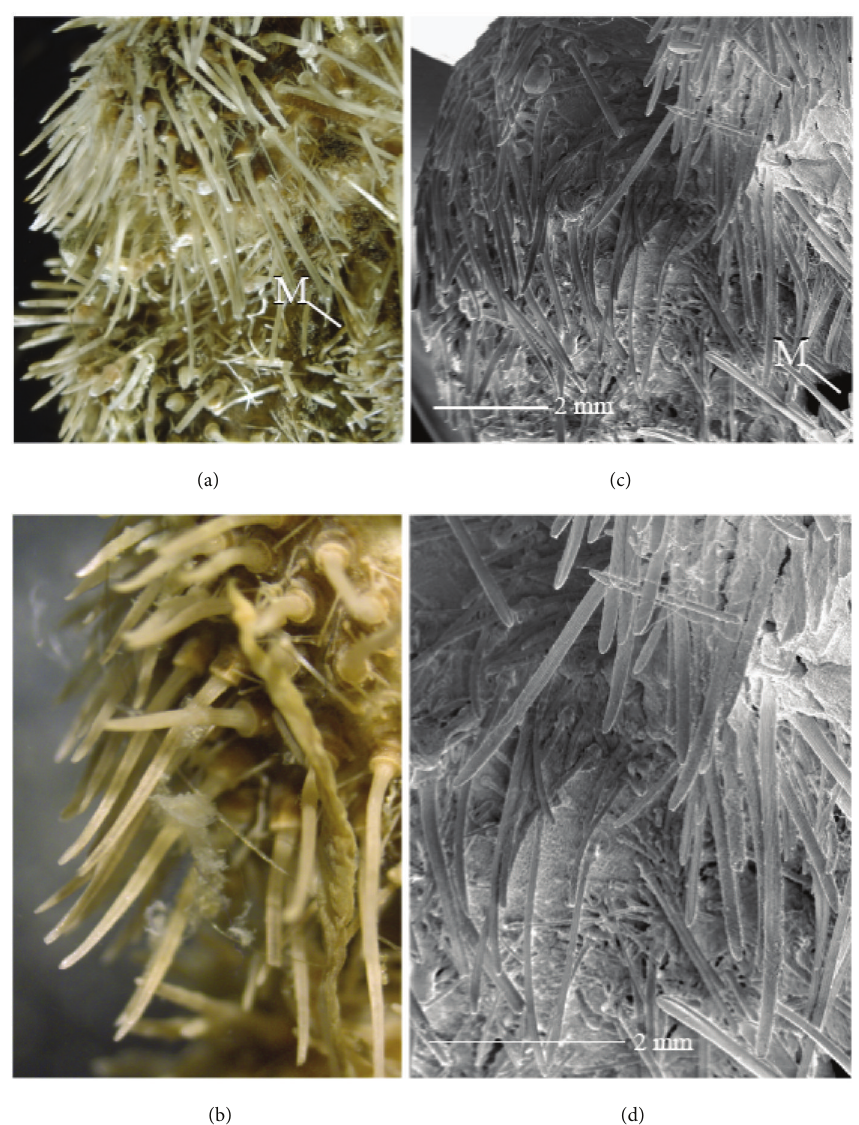
Figure 5: Anterior spines of B. fragilis . ((a) and (b)) Stereomicroscope photographs; ((c) and (d)) SEM micrographs. M: